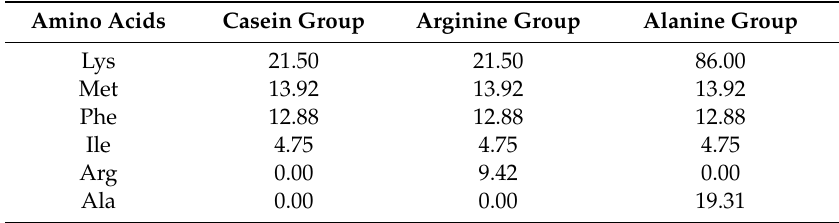
Table 4. Composition of the treatment perfusates (g / L).